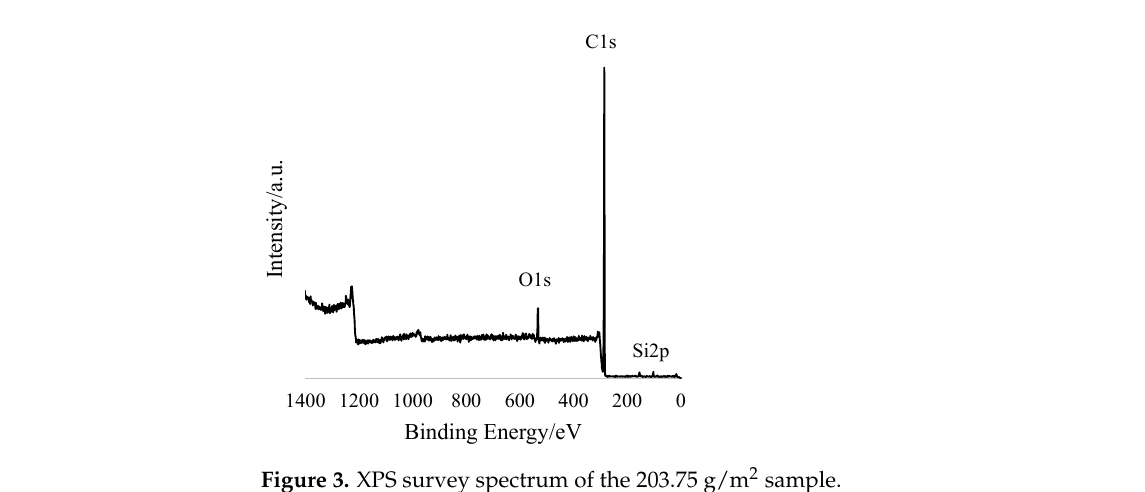
Figure 3. XPS survey spectrum of the 203.75 g/m 2 sample. Table 1. Composition of 203.75 g/m 2 and 295.5 g/m 2 mats based on XPS survey spectra.